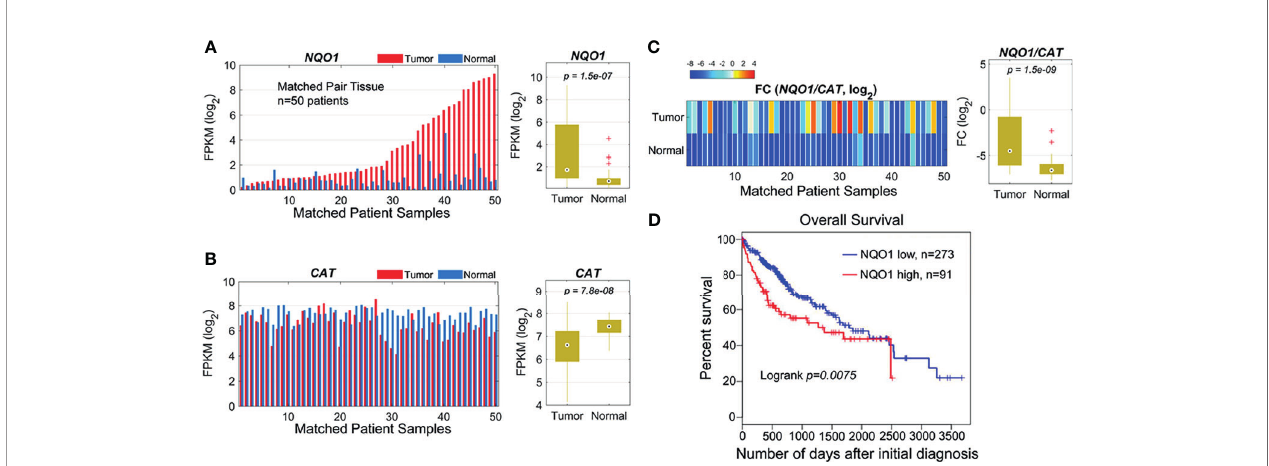
FIGURE 1 | NQO1 and CAT expression pro fi le in matched hepatocellular carcinoma patient samples (n = 50) in the TCGA cohort. (A) Left panel: NQO1 mRNA levels (FPKM, in log 2 scale) in paired HCC tumor and normal liver tissues. The samples were sorted by NQO1 expression levels in tumors. Right panel: Distributions of FPKMs of NQO1 in liver tumor and normal tissues. (B) CAT gene expression in tumor and normal tissues (left panel) and FPKM distributions (right panel). (C) Left panel: The gene expression difference between two genes, NQO1 and CAT (fold change, FC, in log 2 scale), for tumor and normal tissues, respectively. Right panel: Distributions of FCs in tumor and normal tissues. The orders of samples in (B, C) were exactly matched with that in (A) . (A – C) patient samples are 50 total. (D) Kaplan-Meier survival analysis of all HCC patients (low NQO1, N=273; high NQO1, n=91) according to NQO1 mRNA expression in the TCGA database. Days to death: the number of days from the date of the initial pathological diagnosis to the date of death for the case in the